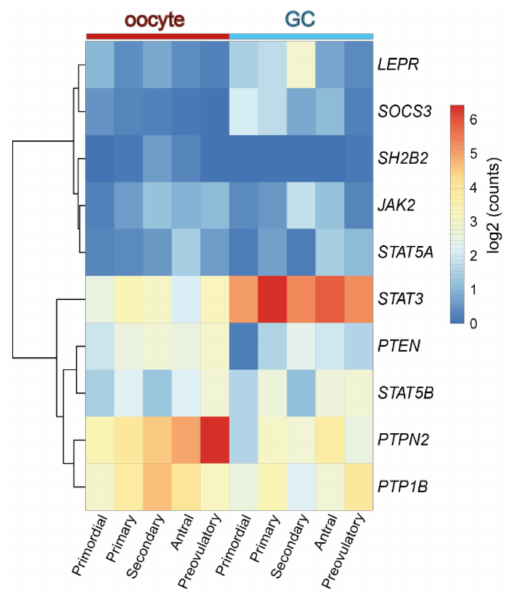
Figure 2. Heatmap representing the expression level of transcripts from the leptin signal- ing pathway components in human oocyte and granulosa cells (GC) throughout folliculogene- sis. Primordial = primordial follicle; Primary = primary follicle; Secondary = secondary follicle; Antral = antral follicle; Preovulatory = preovulatory follicle. Color code from blue to red indicates the relative gene expression level from low to high, respectively. Data from Zhang et al. 2018 [30]. Lep- tin receptor (LEPR), suppressor of cytokine signaling 3 ( SOCS3 ), SH2B Adaptor Protein 1 (SH2B1), Janus kinase 2 (JAK2), signal transducer and activator of transcription (STAT), protein tyrosine phosphatase non-receptor type 2 ( PTPN2 ), protein tyrosine phosphatase ( PTP )